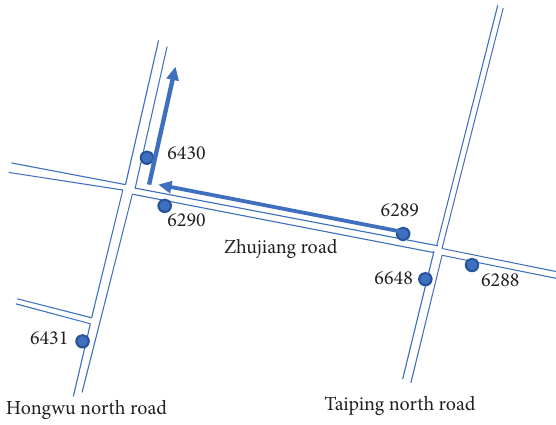
Figure 3: Layout of RFID points and traffic flow direction.